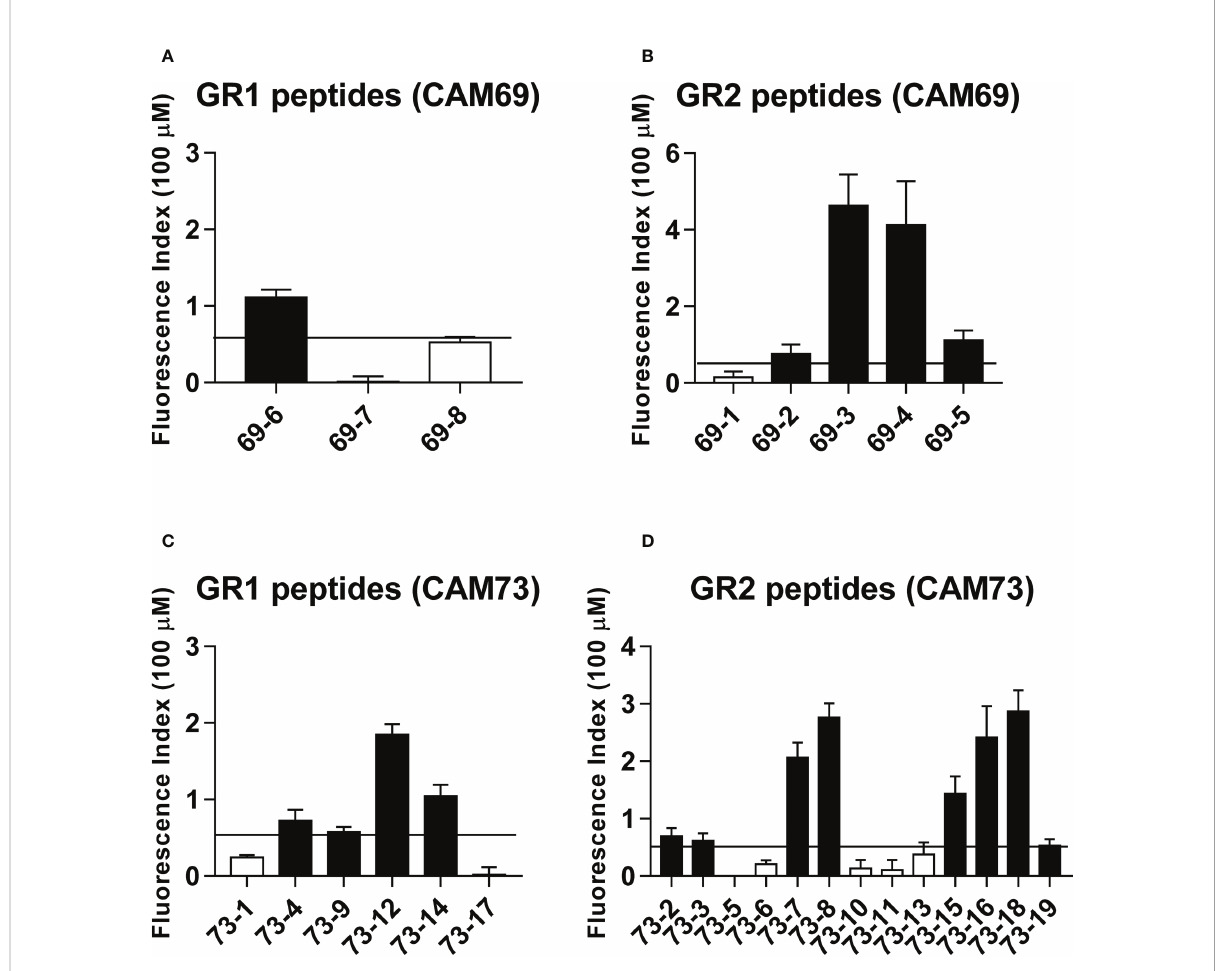
FIGURE 1 Binding of predicted peptide epitopes to HLA-A*02:01 molecules. Peptides from patients CAM69 (A, B) and CAM73 (C, D) belonging to GR1 and GR2 groups were tested at 100 m M in binding assays using T2 cells. Results are expressed as Fluorescence Index (FI) and correspond to the mean of duplicate samples in two experiments. Positive binding was considered when FI > 0.5 (horizontal line) and binder peptides are shown with black